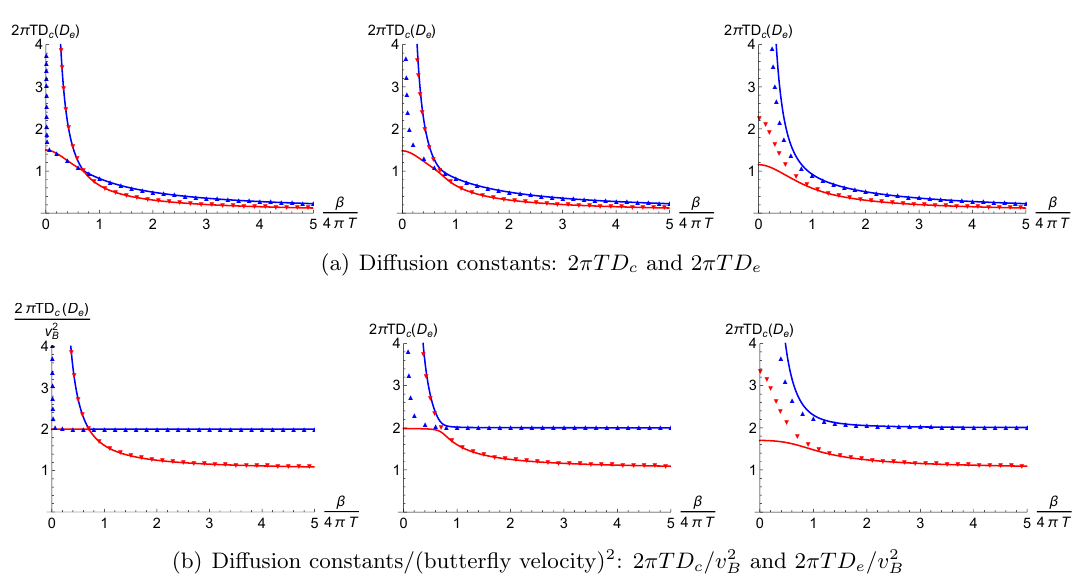
(b) Di(cid:11)usion constants/(butter(cid:13)y velocity) 2 : 2 (cid:25)TD c =v 2